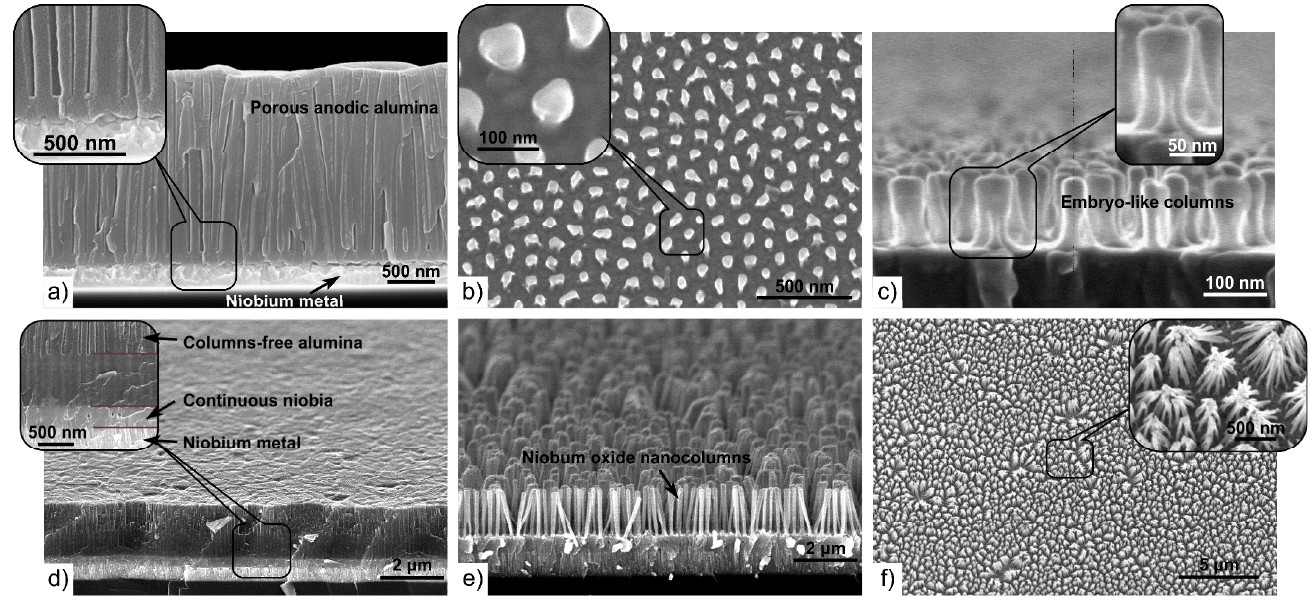
Figure 3. SEM cross-fractured ( a , c – e ) and top surface ( d , f ) views of the first-level column-like anodic niobia 3D nanofilms grown on the Al/Nb bilayer in 0.4 M aqueous H 2 C 2 O 4 via ( a – c ) anodizing at 53 V followed by ( d – f ) reanodizing at 450 V. Images shown in ( b , c , e , f ) were taken after the PAA layer had been dissolved.